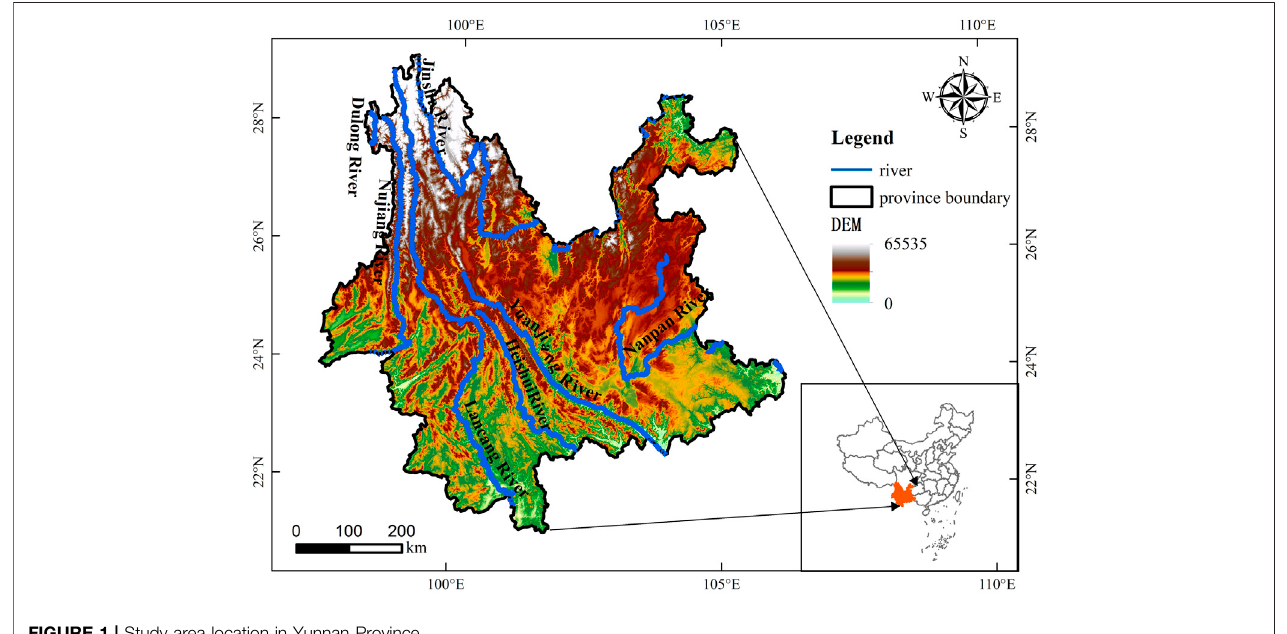
FIGURE 1 | Study area location in Yunnan Province.